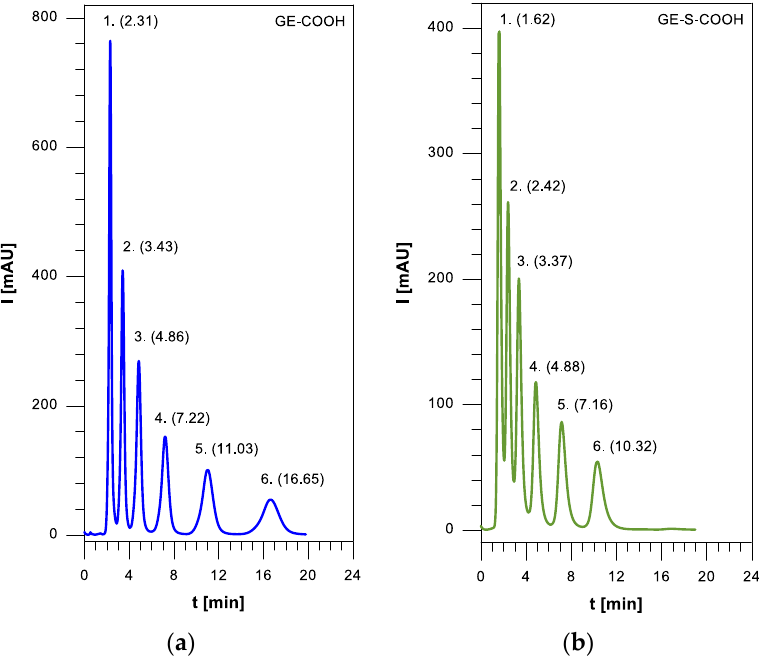
Figure 7. Separation of the mixture of homologous alkyl aryl ketones, ACN-buffer (35:65, v:v): ( a ) GE-COOH; ( b ) GE-S-COOH.